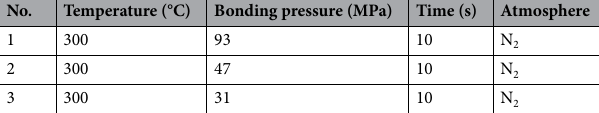
Table 1. Bonding conditions in the 1st step